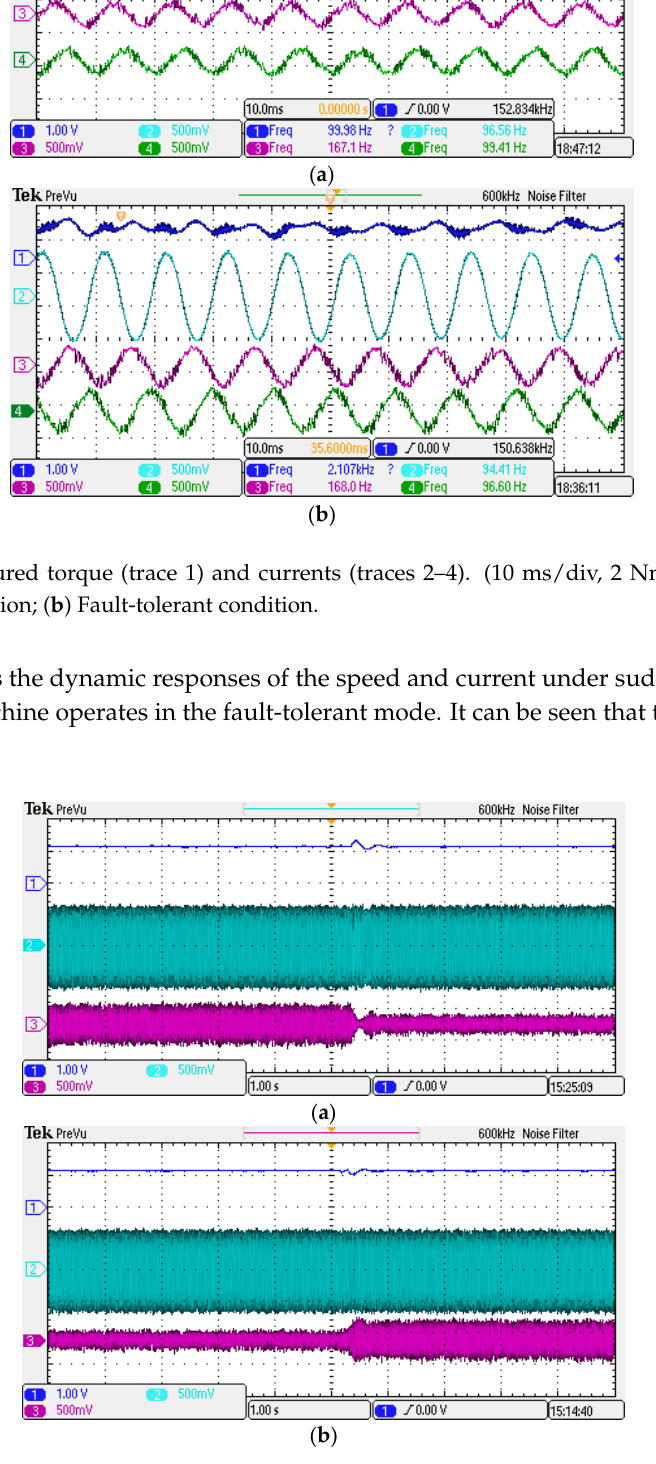
Figure 11. Measured speed (trace 1), short-circuit current (trace 2) and normal current (lower trace 3) responses at a sudden change of load under fault-tolerant condition (1 s/div, 160 rpm/div, 5 A/div): ( a ) Load decrease; ( b ) Load